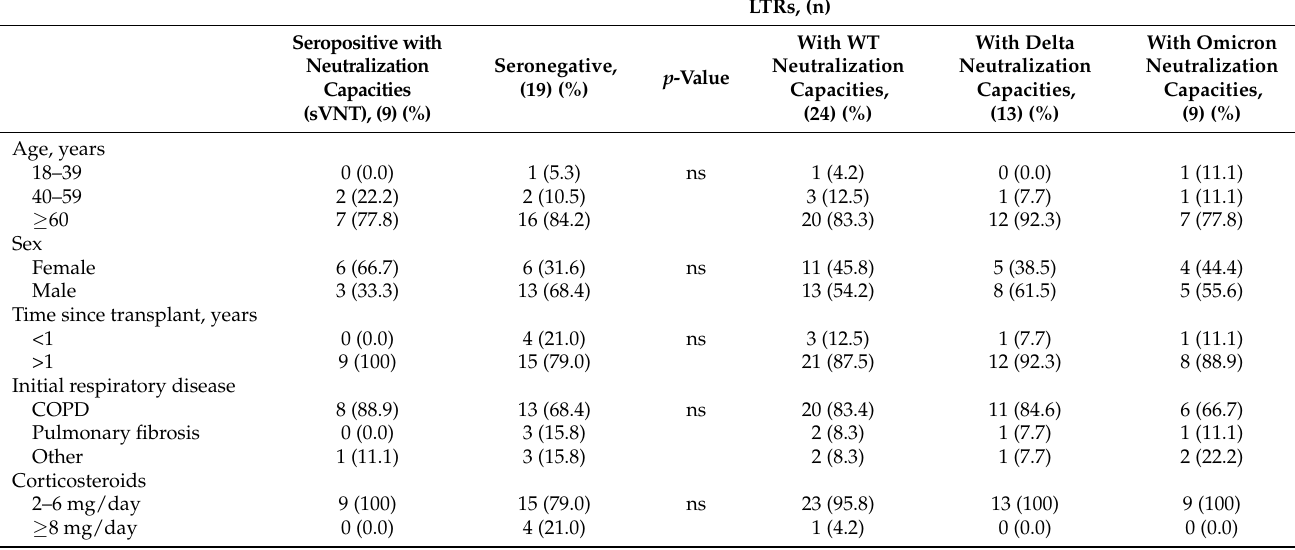
Table 3. Demographic and clinical characteristics of LTRs with stratification by antibody and neu- tralization responses after vaccination scheme completion. Seropositive LTRs with neutralization capacities assessed by sVNT were evaluated at day 238 (n = 9) as well as non-responders (n = 19). Seroneutralization against wild-type SARS-CoV-2 and the Delta and Omicron variants was recorded for LTRs with positive titers for least at one collection time